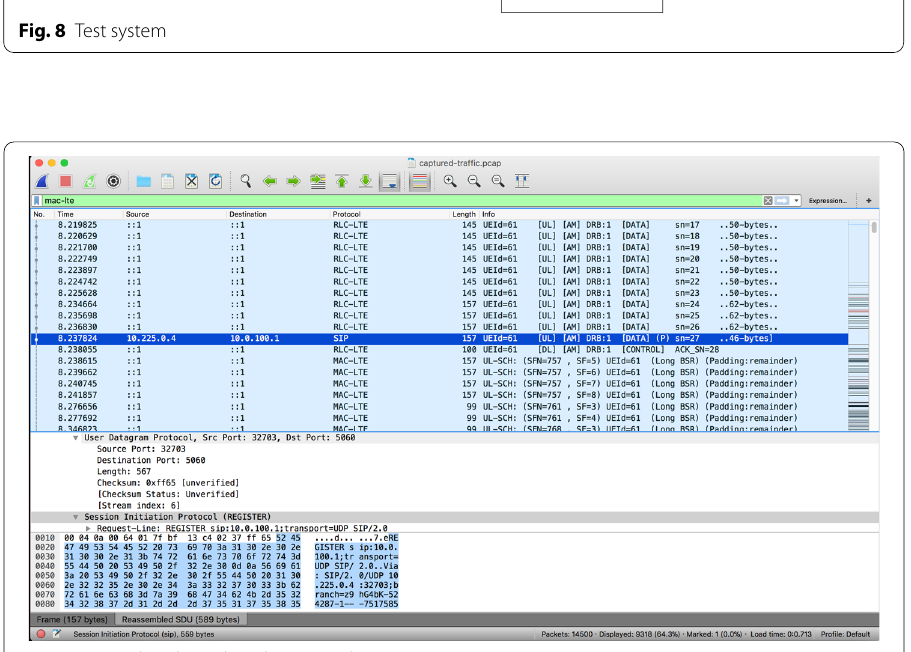
Fig. 9 Protocol analyzer decodes